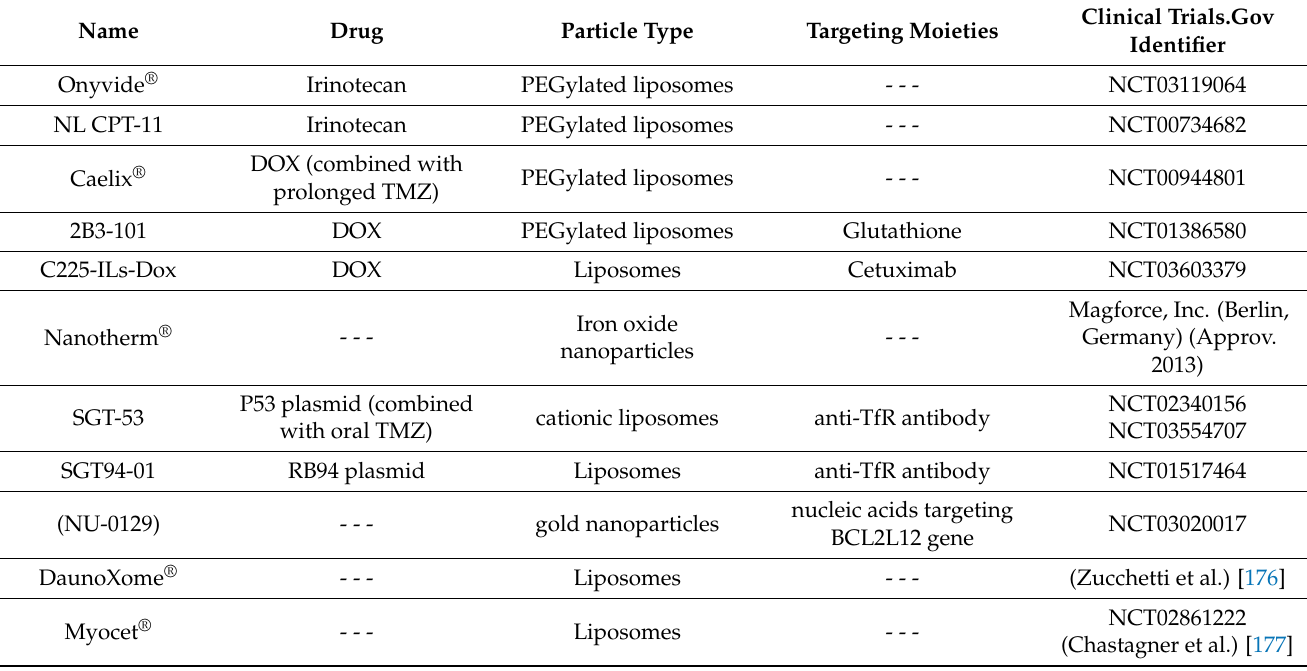
Table 2. Nanoparticle-based systems containing drugs currently undergoing clinical trials for glioma treatment. TMZ: temozolomide; anti-TfR: